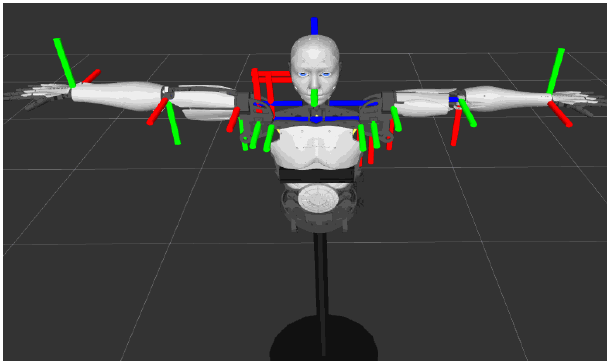
Figure 1. DOF of the humanoid robot (DOF of fingers are not